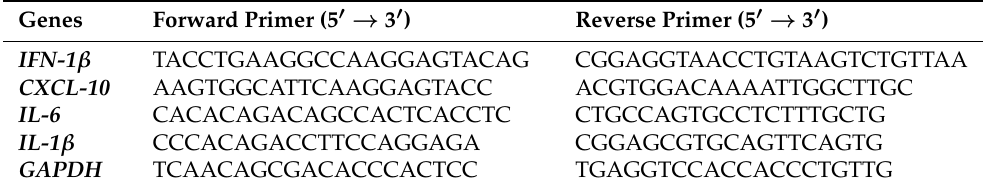
Table 2. List of